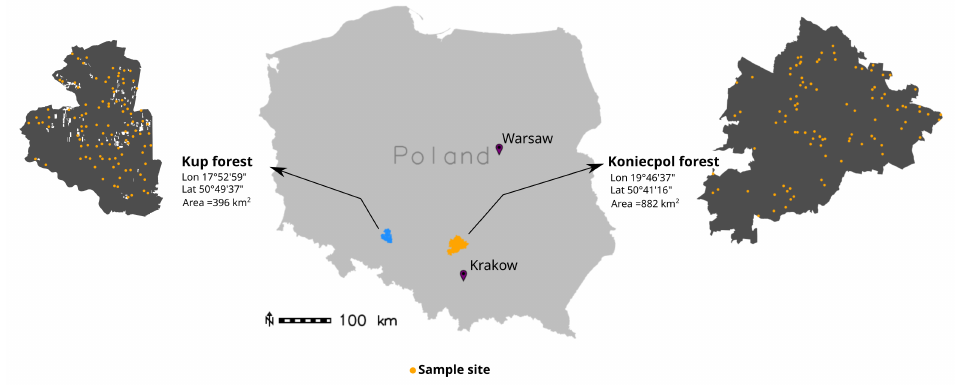
Figure 1. The sampling locations are marked with points. The two study sites are overlaid on the Poland map. The Kup ( left ) and Koniecpol ( right ) forest districts are